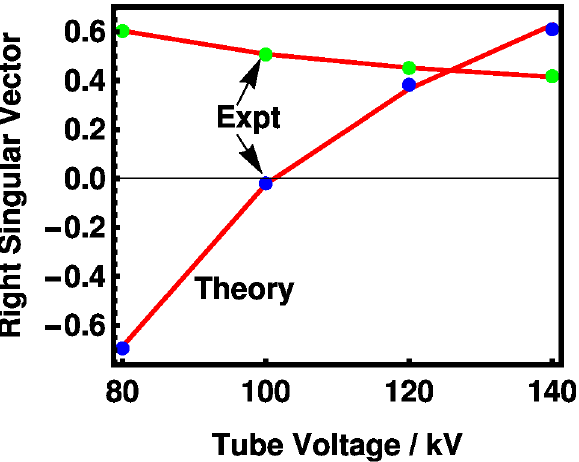
Fig 7. The components of the first two right singular vectors of the molar HU potency matrix, as indexed by the tube voltages, are shown for theory (red lines) and experiment (first, green dots; second, blue dots).